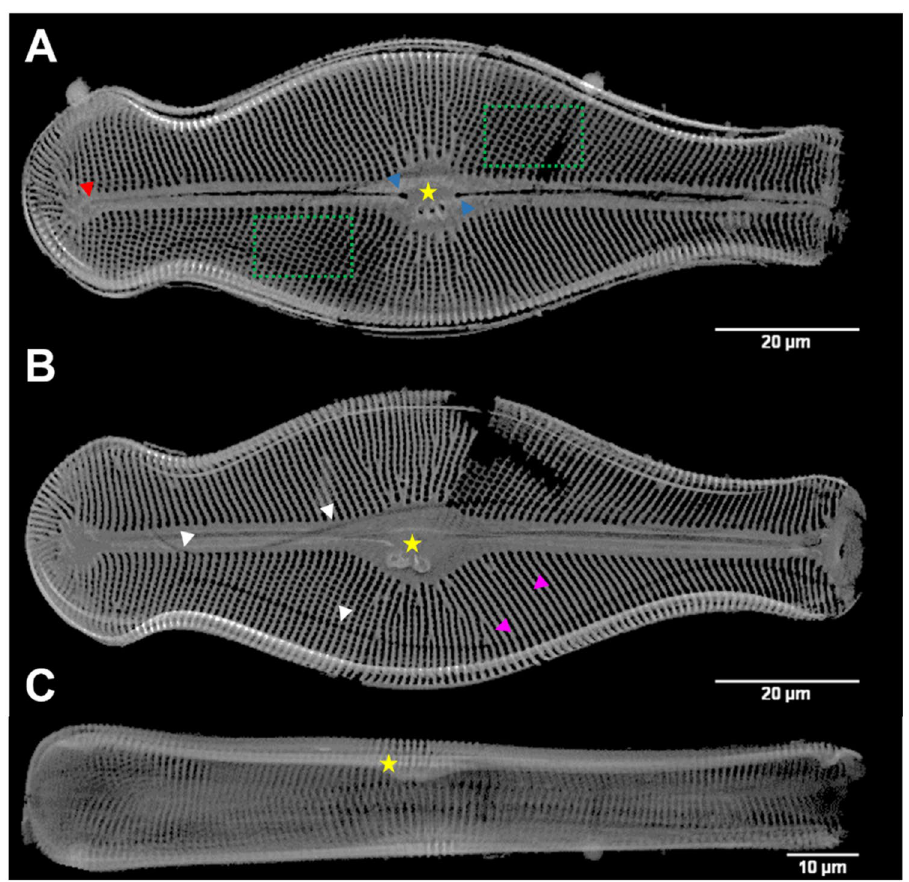
Figure 2. Nano-XCT of the frustule of D. geminata (in phase contrast imaging mode). ( A – C ) Slices extracted from the reconstructed 3D volume in ( A ) valve view – epitheca, ( B ) valve view of the interior – hypotheca, and ( C ) girdle view of the frustule. Yellow star: stigmata, red arrowhead: raphe distal end, blue arrowheads: raphe proximal ends, purple arrowheads: ribs, white arrowheads: girdle band, green rectangle: pores/areolae.